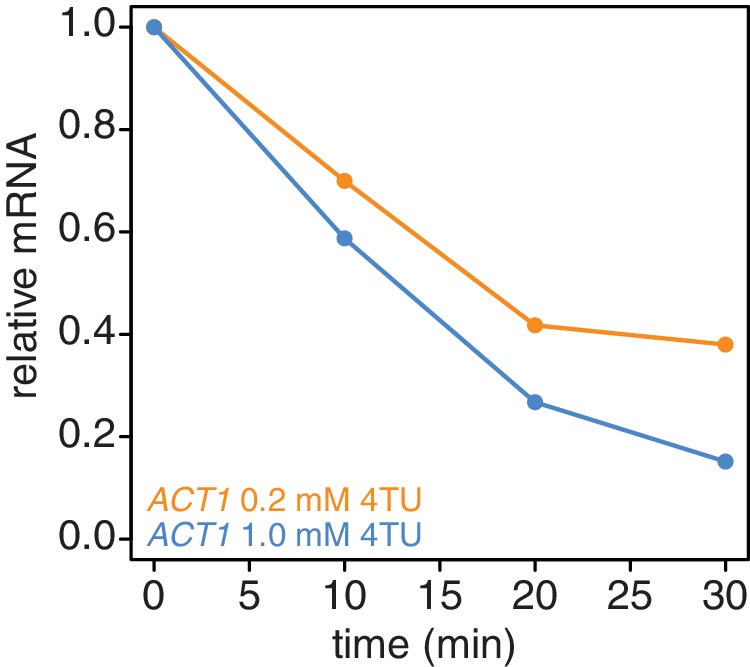
Increasing the 4TU concentration during the chase improves the subtraction of newly synthesized mRNAs.Wild-type cells (KWY165) were subjected to the 4TU-chase protocol with either 0.2 mM 4TU in the chase (orange) or 1 mM 4TU (blue) and the unlabeled ACT1 mRNA levels were quantified.